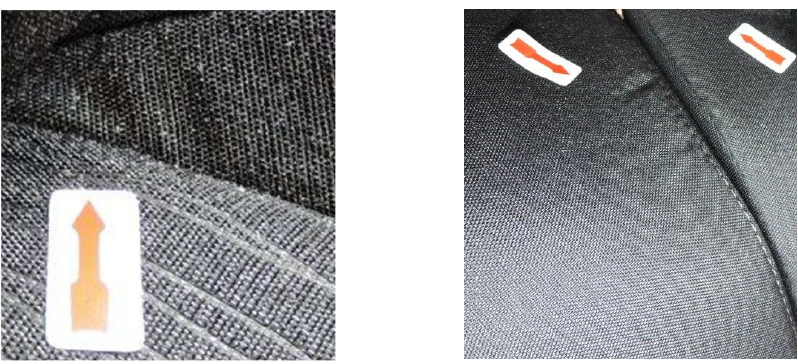
Figure 1. The investigated appearance defect of a laminate textile—fabric wrinkling.